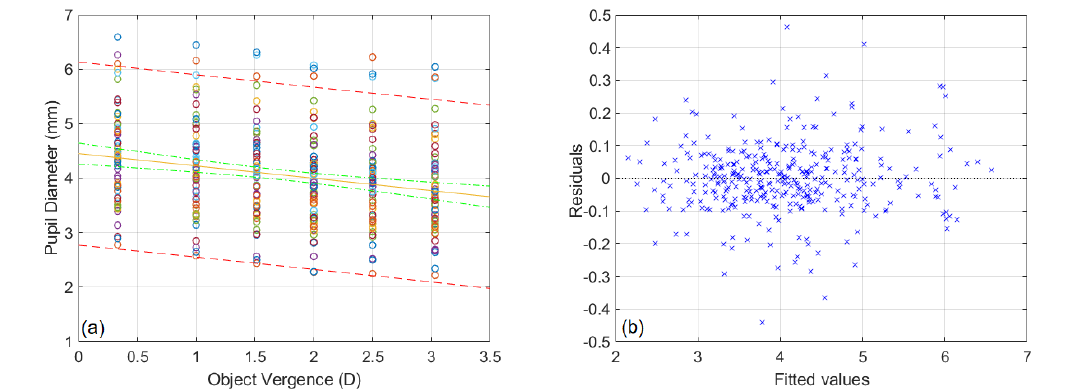
Figure 3. ( a ) Fixed effect fit and 95% confidence limits for the mean (dashed green line) and for a single prediction (dashed red line) for a given value of pupil diameter. ( b ) Scatter plot of standardized residuals versus fitted values for the first mixed effects model.